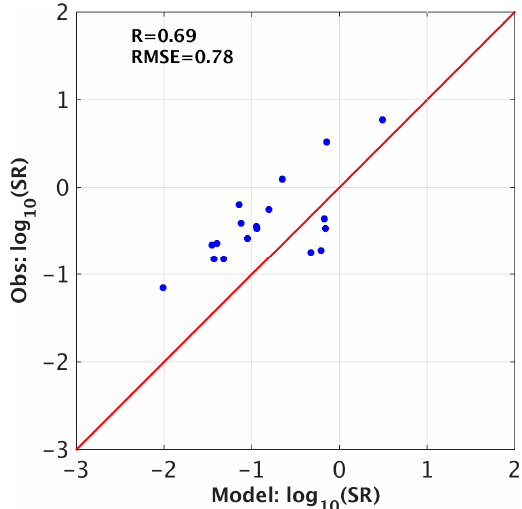
Figure 7. 20-year averaged annual sediment deposition rate comparison between simulation and observations (SR: Sedimentation rate; unit: log 10 cm/year). Rates were derived from the profiles of 210 Pb with depth in the